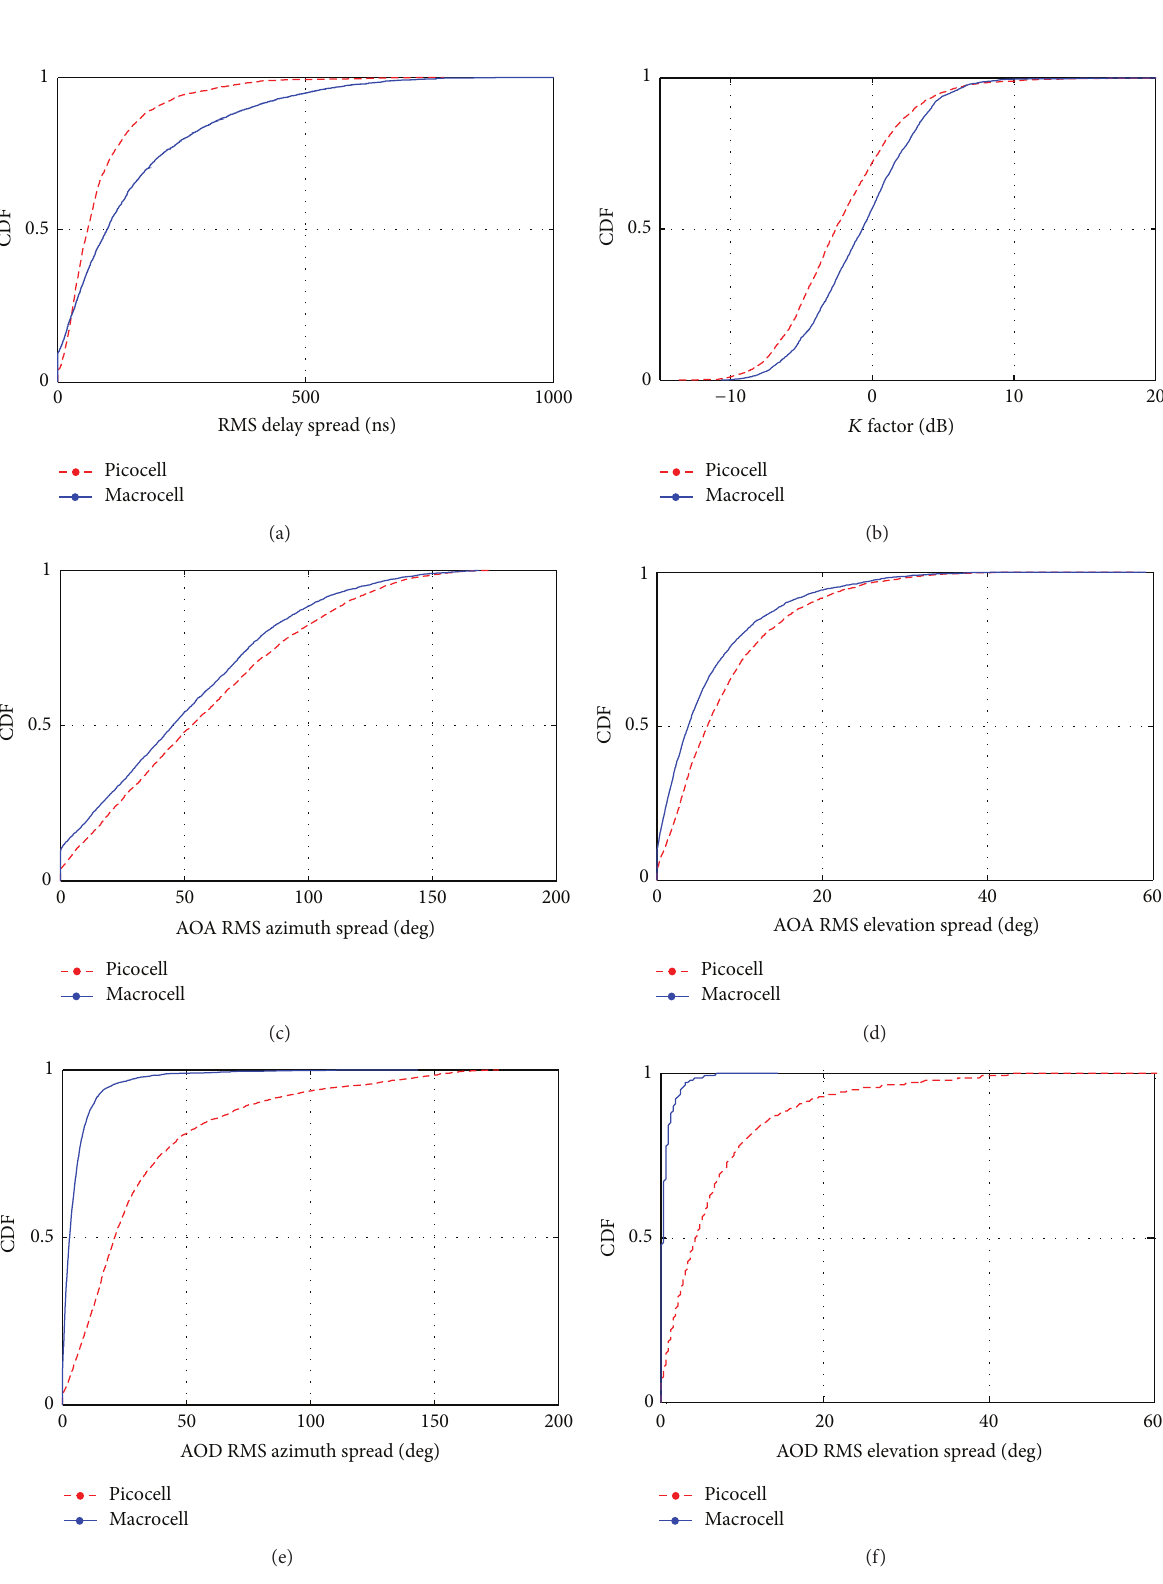
Figure 7: CDFs of macrocell and picocell propagation